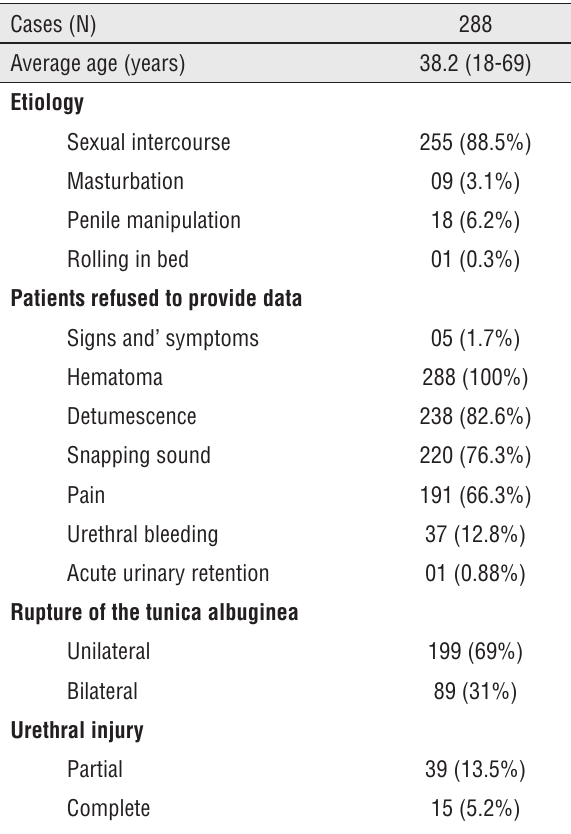
Table 1- Demographic data and intra-operative